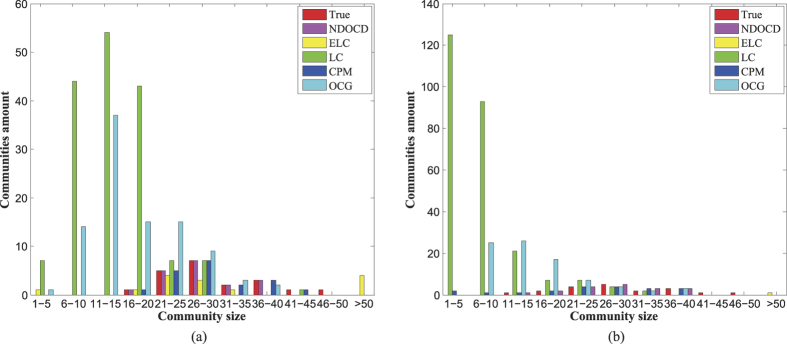
Histogram of the detected community sizes on LFR benchmark.(a) Comparison on networks with n = 500, k = 25, kmax = 50, u = 0.1, τ1 = 2, τ2 = 1, cmax = 50, cmin = 10, om = 2, on/n = 10%, (b) Comparison on networks with n = 500, k = 25, kmax = 50, u = 0.4, τ1 = 2, τ2 = 1, cmax = 50, cmin = 10, om = 2, on/n = 10%.